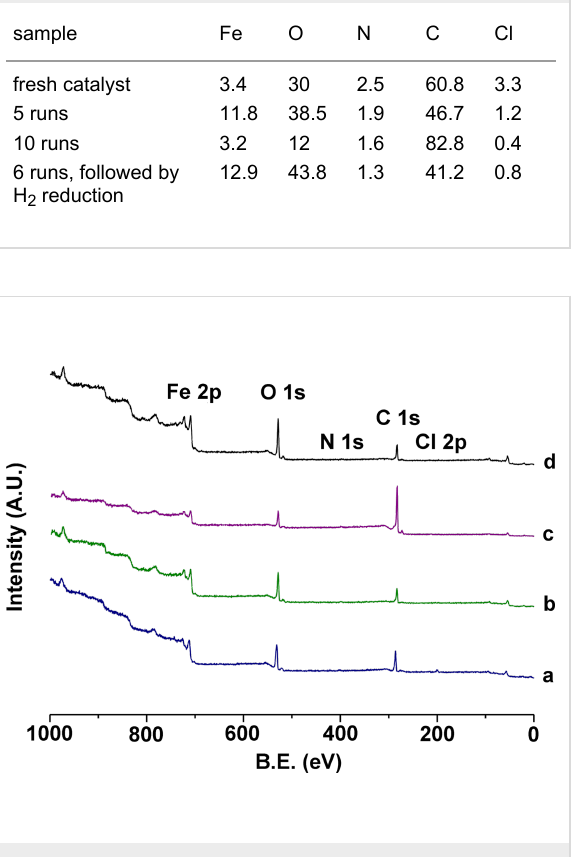
Figure 5: XPS surveys of the catalyst: a) as prepared with HDA syn- thesis, b) after 5 runs, c) after 10 runs, d) after 6 runs, followed by H 2 reduction. Catalytic runs were performed for 2 h at 400 °C.